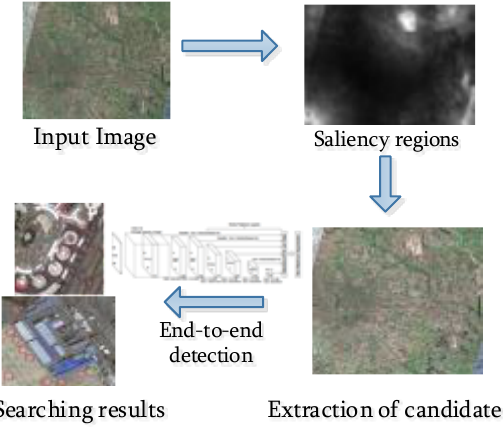
Figure 1. The work flow structure